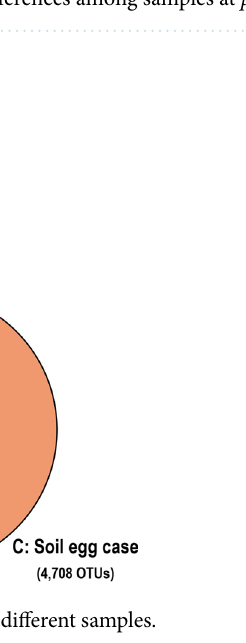
Table 1. Mean ± SD (standard error) of alpha diversity indexes of OTUs from different samples. Different letters in the same column indicate significant differences among samples at p = 0.05.